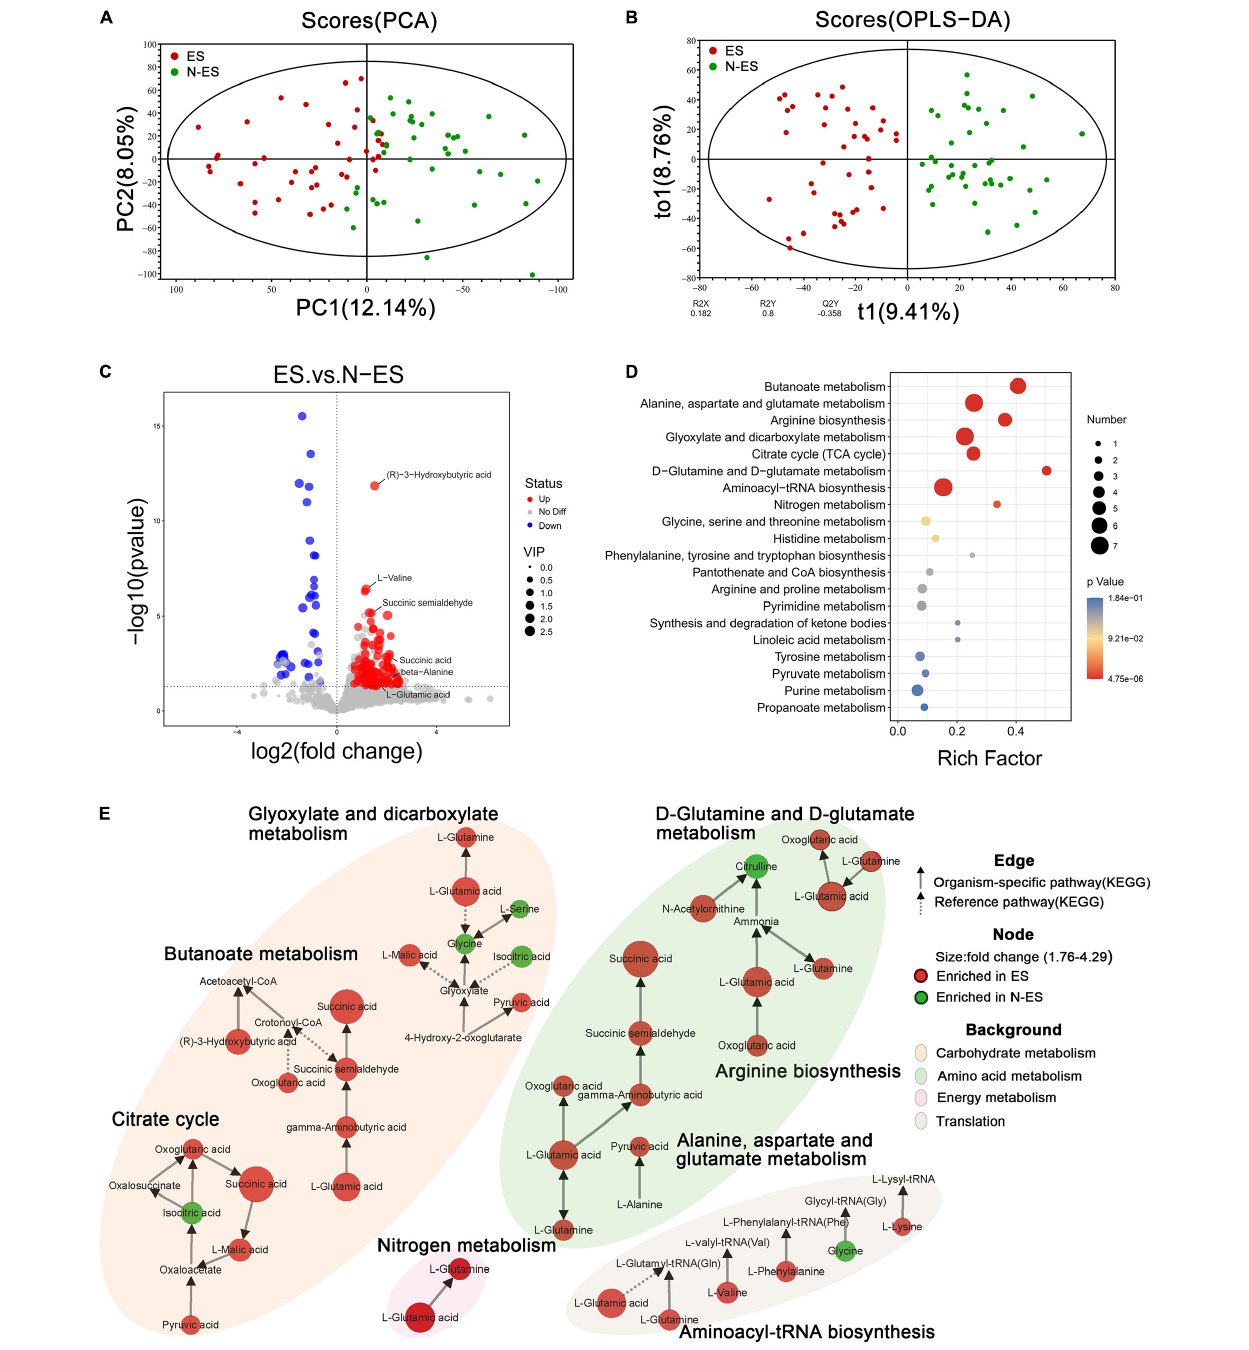
FIGURE 4 | Discrepant metabolic patterns in elite soldiers (ES) and non-elite soldiers (N-ES). (A,B) The clustering analyses of principal component analysis (PCA) and orthogonal partial least-squares discriminant analysis (OPLS-DA). (C) Volcano plots showing the P -value ( y -axis), fold-change ( x -axis), and variable important in projection (VIP, node size) of the qualitative metabolites identified in the metabolomics analysis. The color of the circle represents differential metabolites (VIP > 1, P < 0.05 Student’s t -test) with enrichment (red) or depletion (blue) in ES group. (D) Bubble diagrams showing the top 20 enriched Kyoto Encyclopedia of Genes and Genomes (KEGG) pathways for the differential metabolites. Abscissa variations indicate the degree of enrichment (Rich factor), and the vertical axis shows the KEGG pathway information. The color scale indicates significance levels, and the node size represents the number of discriminative metabolites in the mapping pathway. (E) The significantly enriched KEGG pathway ( P < 0.05 hypergeometric test) of the differential metabolites. Identified metabolites are represented by nodes with the size reflecting fold change. Each node is labeled with red (enriched in ES cohort) or green (enriched in N-ES cohort). The solid and dotted arrows symbolize organism-specific and reference pathways, respectively, according to the KEGG database. The disparate color shadows highlight the pathway at KEGG level 2.